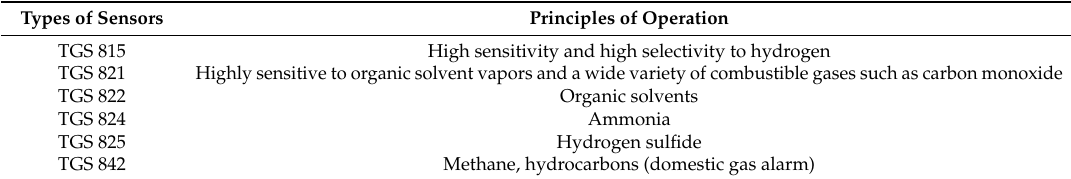
Table 1. Types of sensors used in the electronic nose and their principles.